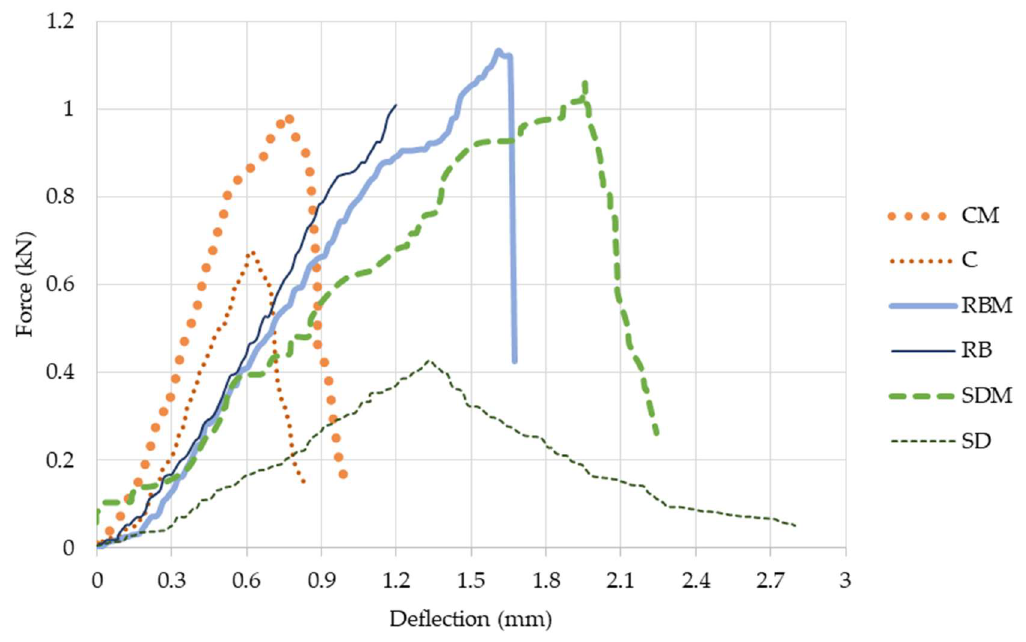
Figure 8. Force-displacement diagram of all mix design (C, CM, RB, RBM, SD, and SDM) taken from sample specimen.